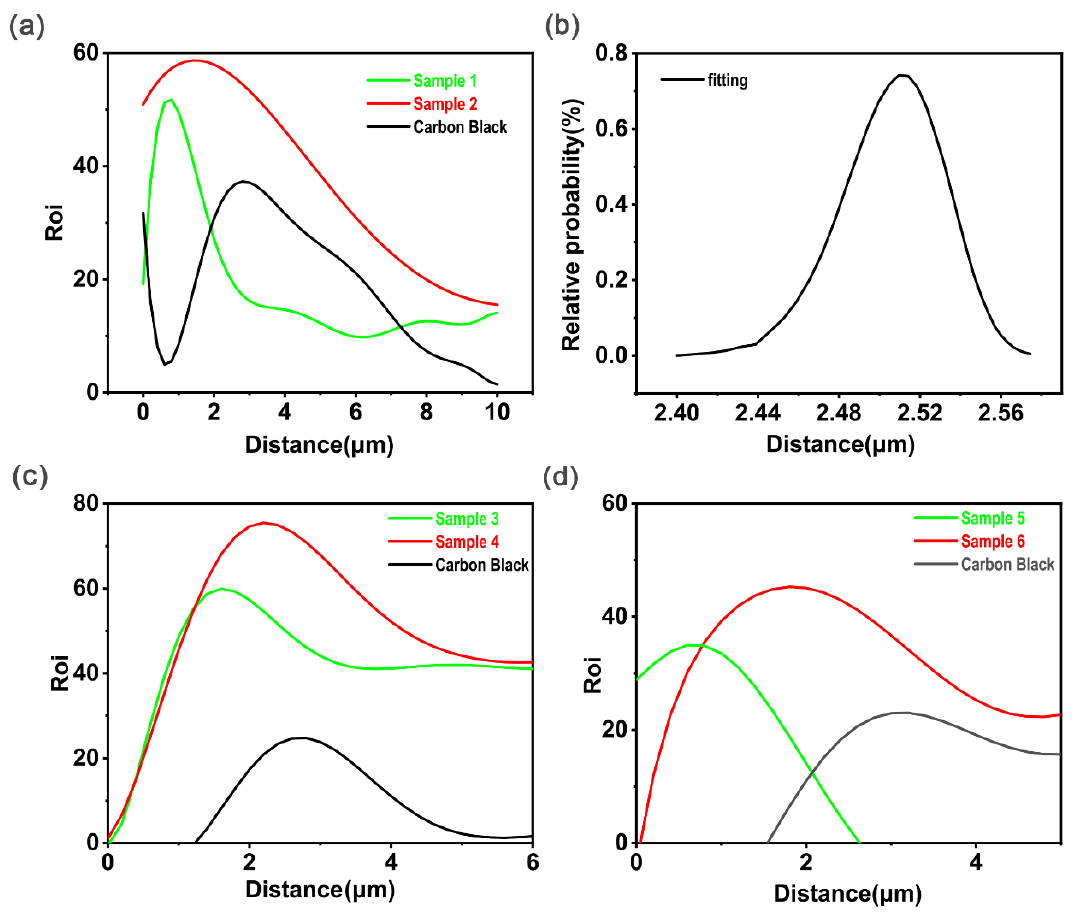
Figure 12. ( a ) Cross-sectional EDS images of samples 3 and 4 after ion implantation with experimental measurements. ( b ) Model-calculated distribution of carbon black particle concentration in the sample cross section after ion implantation. ( c , d ) Cross-sectional EDS images of samples 1, 2, 5, and 6 after ion implantation with experimental measurements.